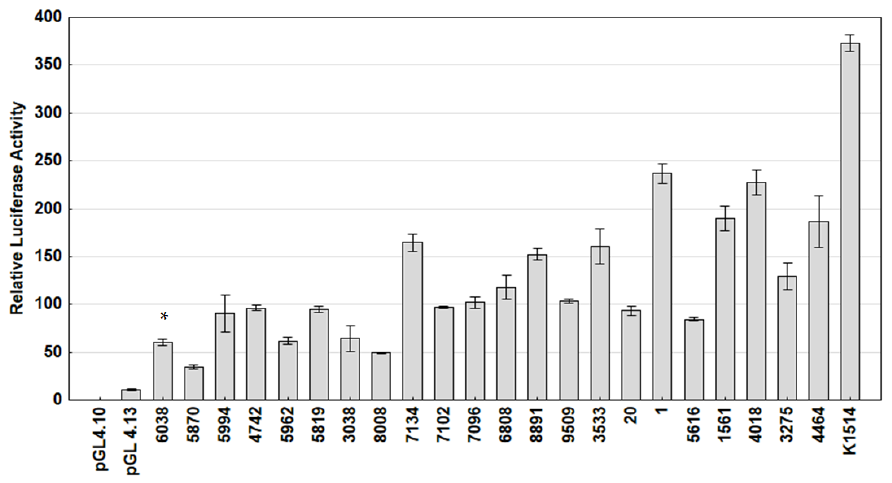
Figure 3. Basal transcriptional activity of SRLV LTR variants in TIGEF cells. Results present the mean of three independent transfection experiments, and standard deviations are shown as error bars. The asterisk indicates a significant difference ( p < 0.05) with the reference strain K1514 LTR according to the Mann–Whitney U Test.